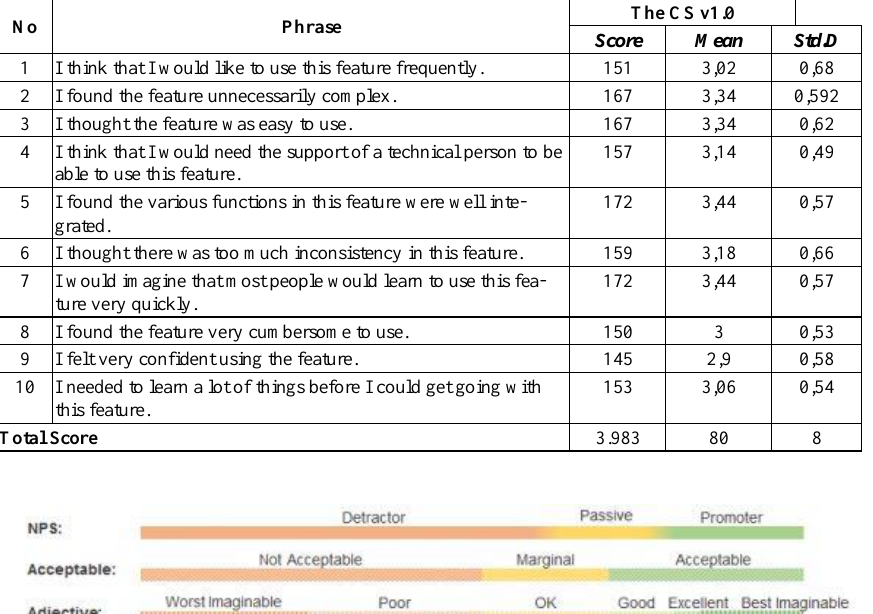
Table 3. SUS questionnaire result